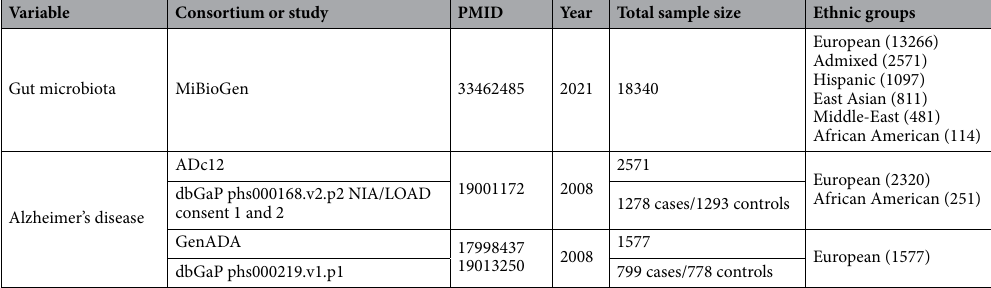
Table 1. Information for studies used in our analyses. Information for the data used in this study. The Multi- ethnic cohorts of the MiBioGen study include 16 European cohorts (n = 13266), one Middle Eastern cohort (n = 481), one East Asian cohort (n = 811), one American Hispanic/Latin cohort (n = 1097), one African- American cohort (n = 114), and four cohorts of multi-ancestry individuals (n = 2571). The Multi-ethnic cohort of the NIA/LOAD study contains African-American (n = 251) and Caucasian individuals (n = 2320).